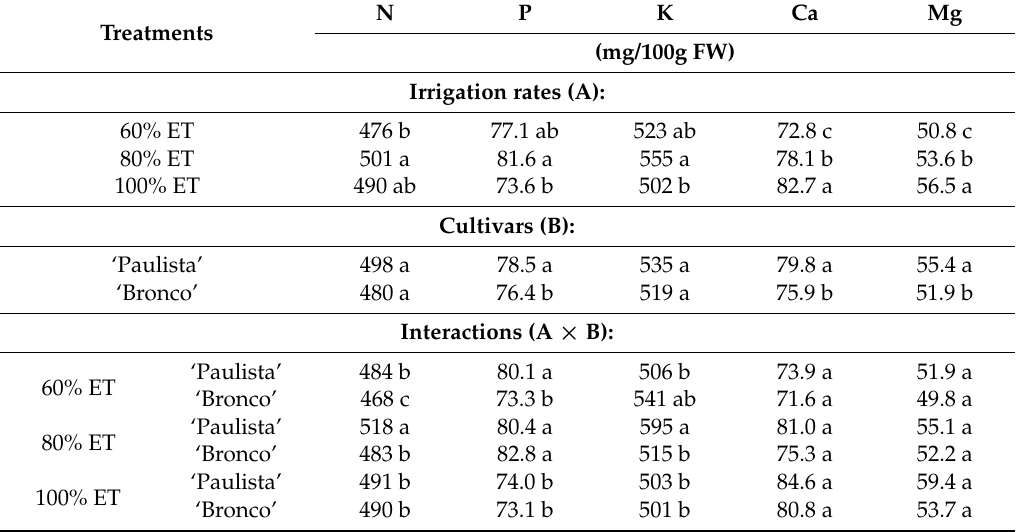
Table 4. Effect of different irrigation water volumes based on supplying 60, 80 or 100% of evapotranspiration (ET) on the content of macroelements for two green bean cultivars.